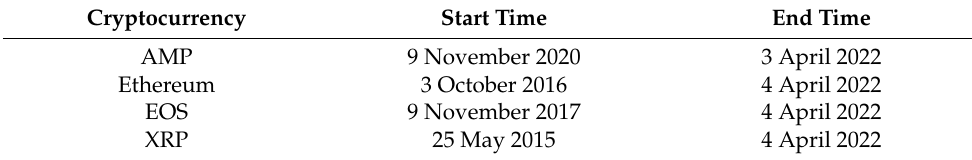
Table 2. Period used for each cryptocurrency.